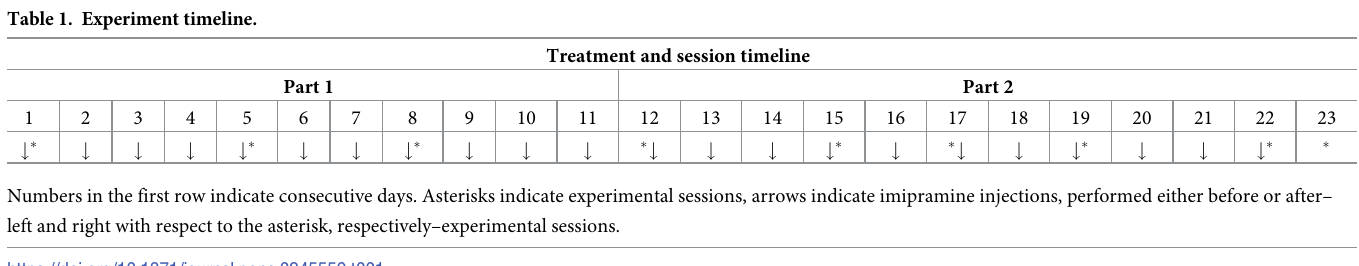
Table 1. Experiment timeline.